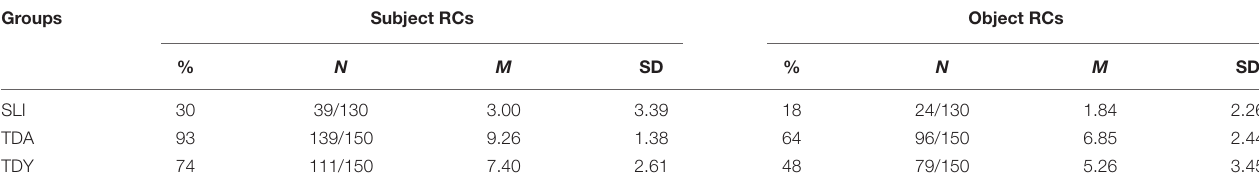
TABLE 4 | Numbers (N), percentage (%) (non-target RCs/all responses) of the non-target RCs in each group. Object RCs with thematic role reversal